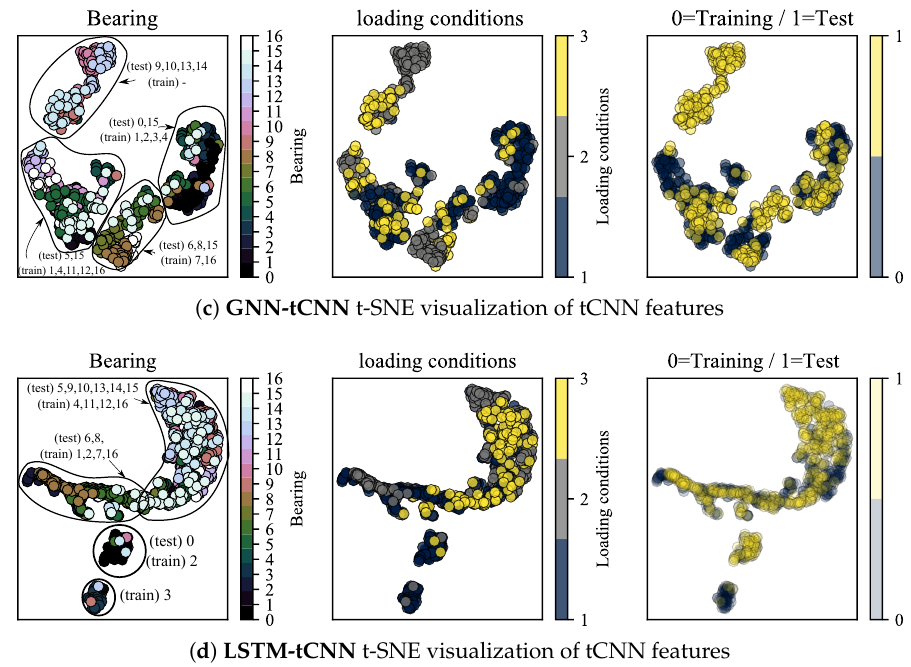
Figure 11. t-SNE visualization of tCNN features for segments close to